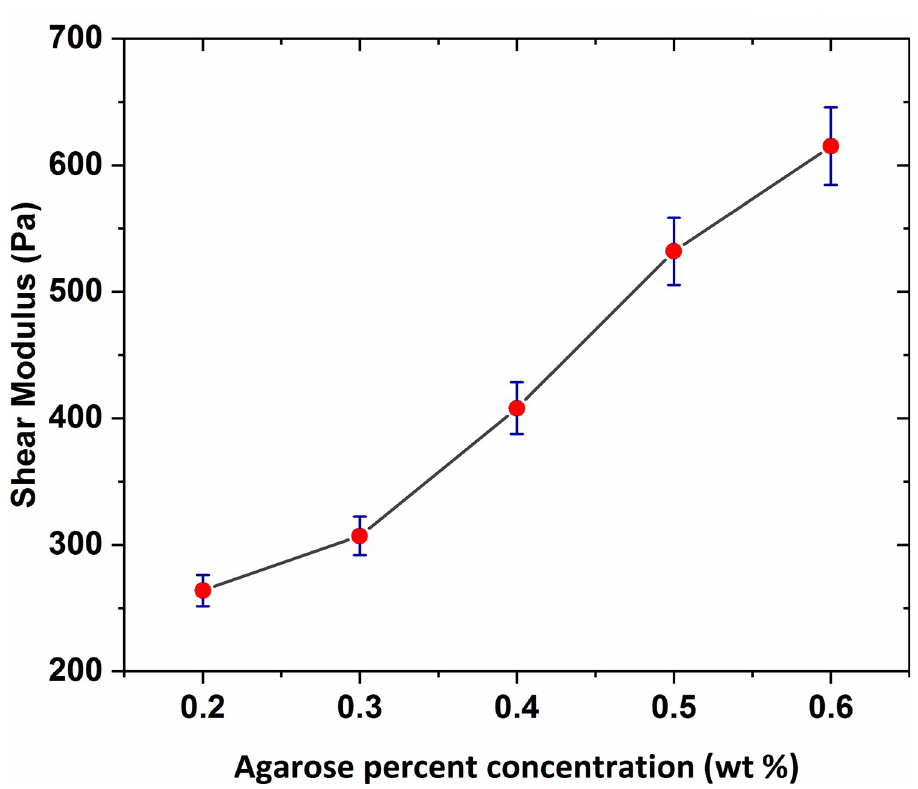
Fig 12. The graph of elastic shear modulus of agarose hydrogel versus agar percent concentration with error bars based on a 95% confidence interval from the linear fitting procedure.